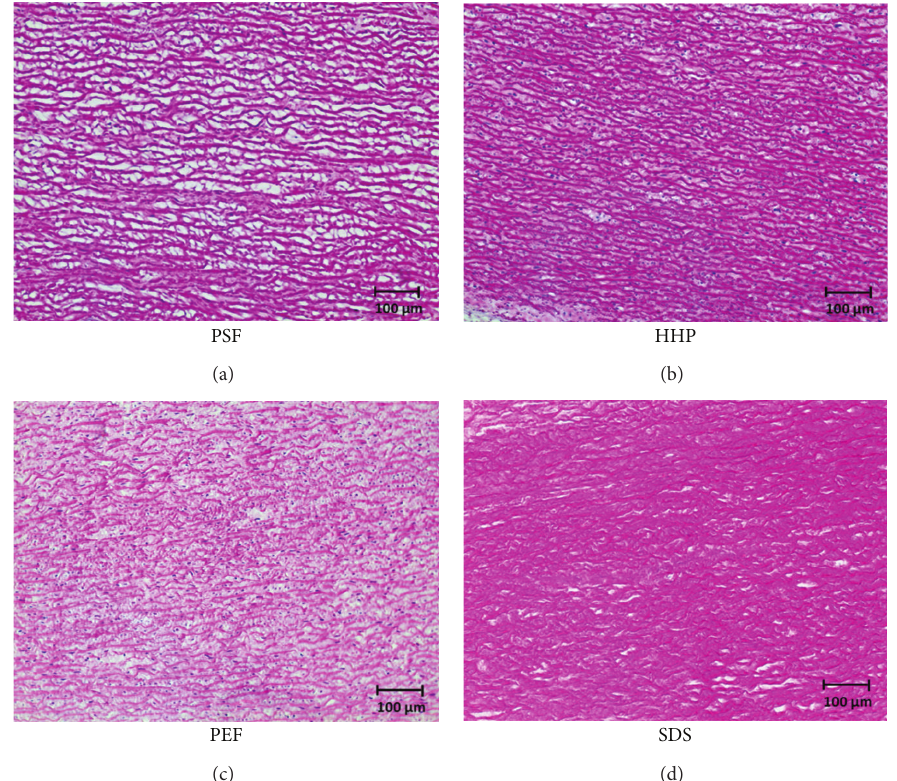
Figure 3: Images of the HE-stained sections (200x Magnification). In PSF-and-SDS treated tissue, all nuclei had successfully been removed. In PEF- and HHP-treated tissue, nuclei could still be detected.